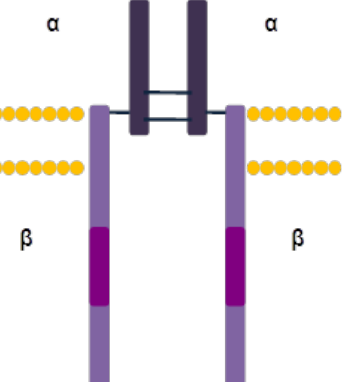
Figure 3. IGF-1R